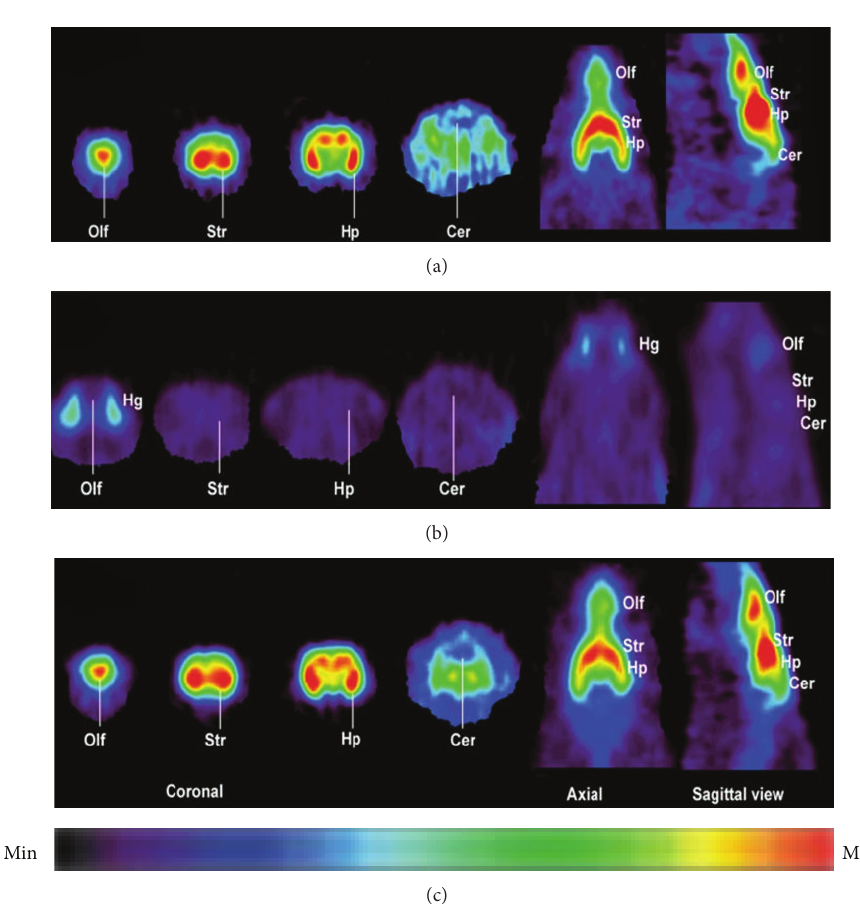
Figure 11: PET images of [ 18 F]FPEB (20–25 min) in rat brain without drug treatment (a), treatment of mGluR5-selective ligand MTEP treatment (10mg/kg) (b), and treatment of mGluR1-selective YM-298198 (10mg/kg)